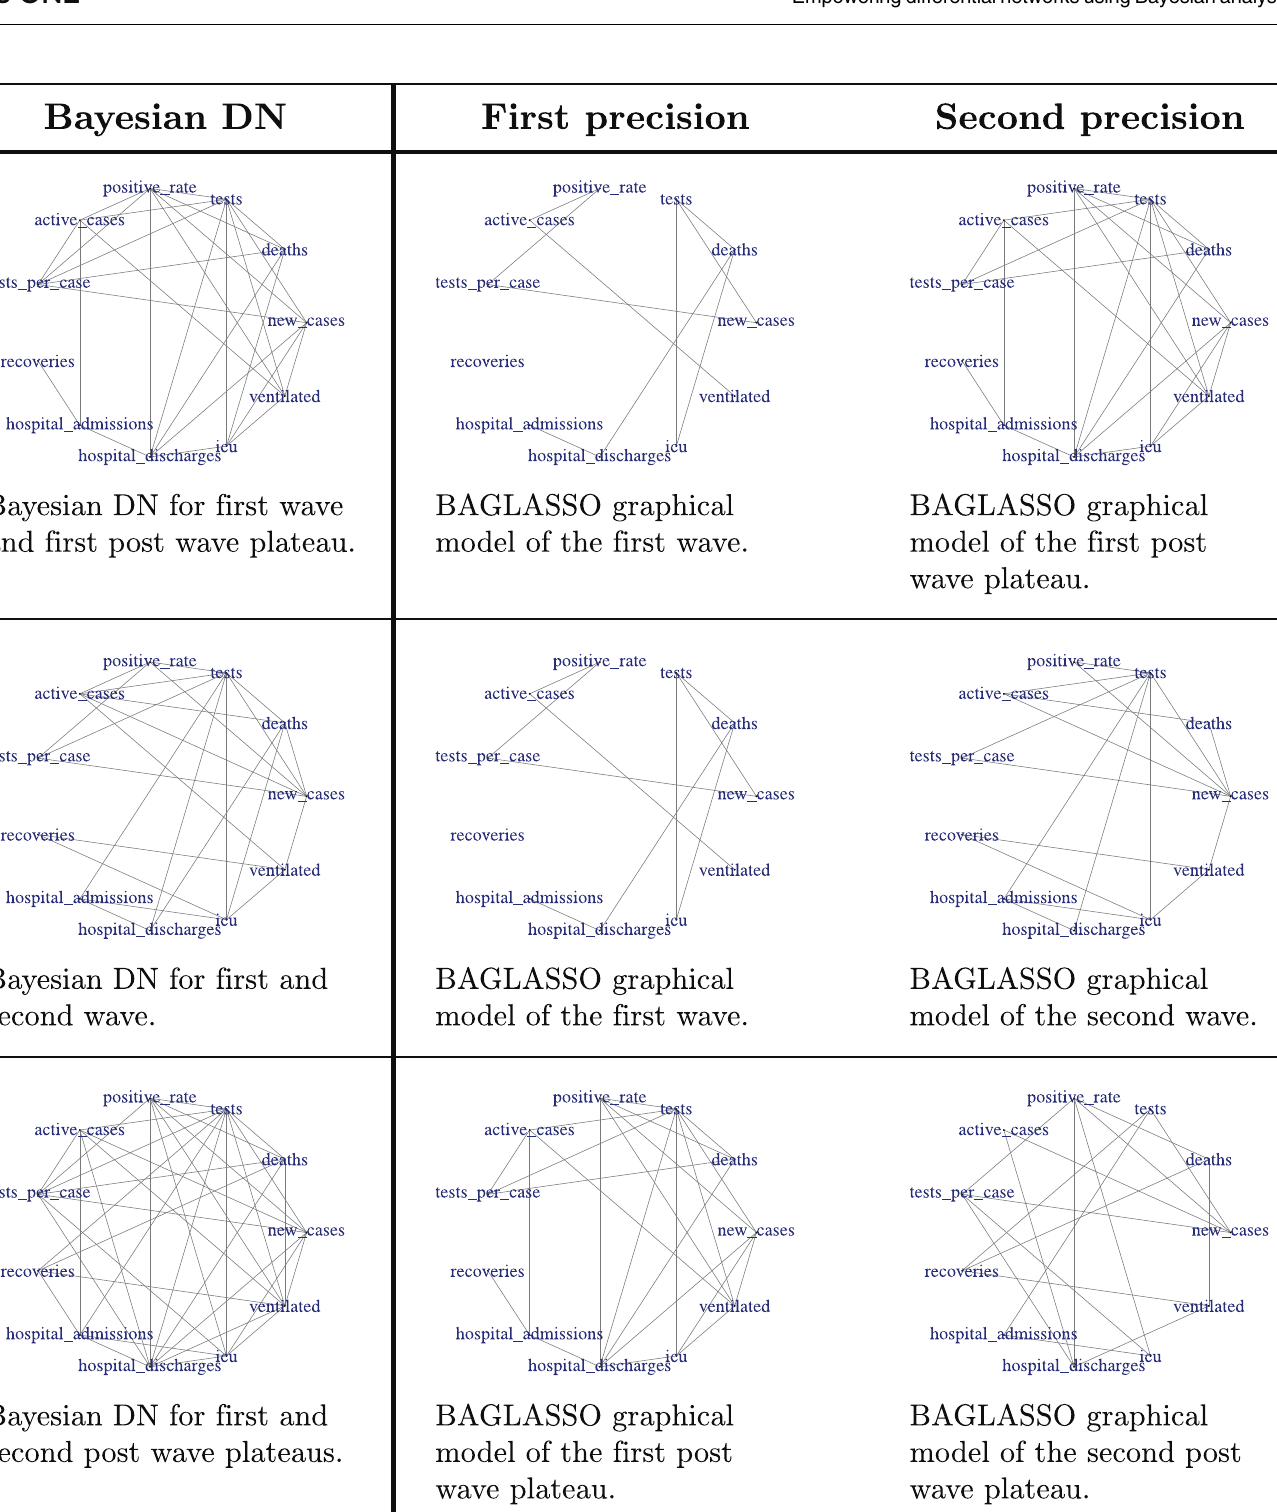
PLOS ONE | https://doi.org/10.1371/journal.pone.0261193 January 25,